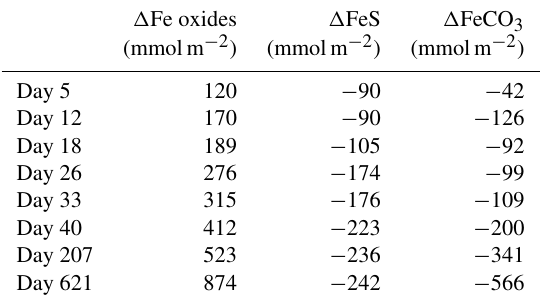
Table 3. Mass balance of Fe. Time series of the depth-integrated (0–5cm) increase in Fe oxides and the depth-integrated (0–5cm) depletion of FeS and FeCO 3 (siderite) in mmolm − 2 . All values are reported in mmolFem − 2 . Negative values represent a decrease, whereas positive values indicate an increase in the mineral